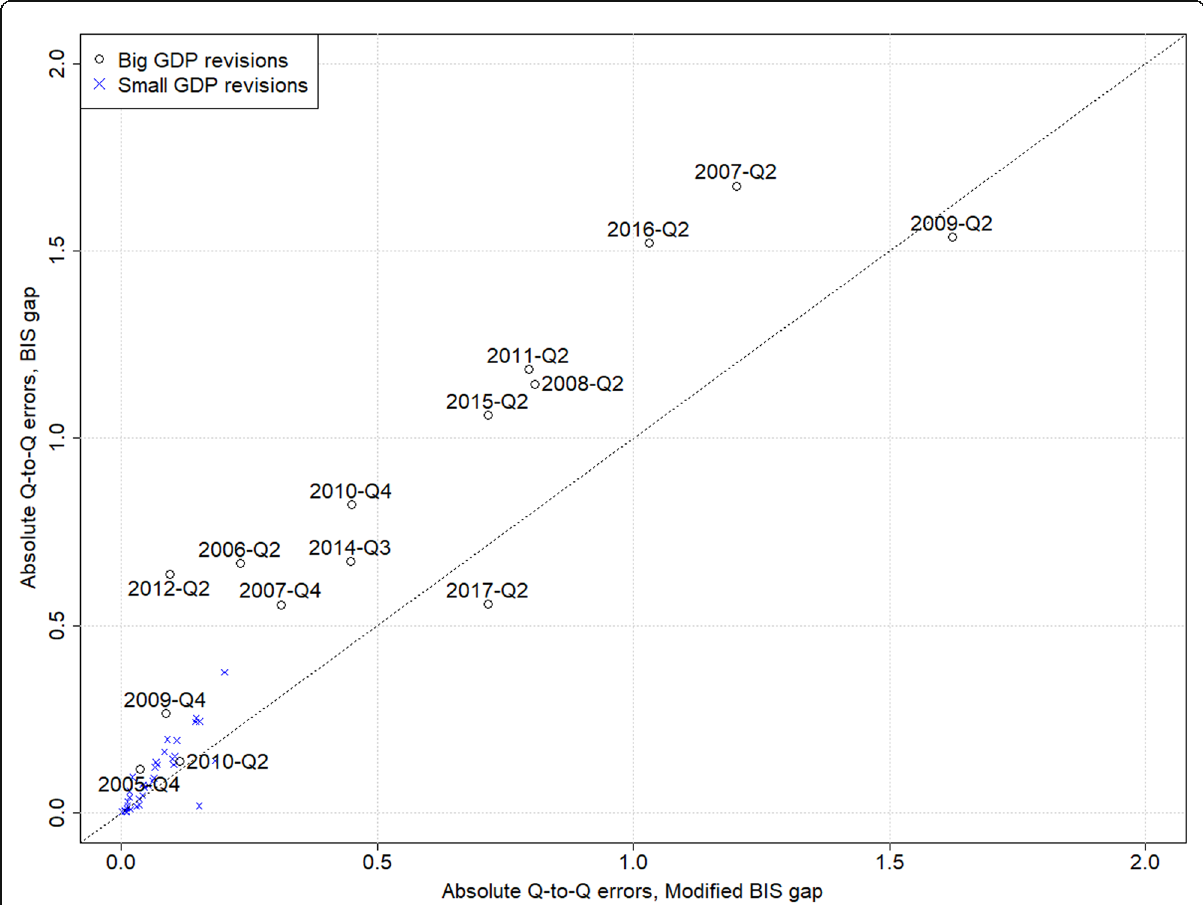
Fig. 5 Absolute quarterly errors resulting purely from GDP revisions. BIS gap ( y -axis) vs. modified BIS gap ( x -axis) in percentage points. Note: A GDP revision is classified as “ big ” if its relative difference, in absolute value, to the previous quarter ’ s vintage is larger than 0.66% at least once (see Fig. 3, in which 15 GDP vintages have at least one revision of greater than 0.66% and are denoted with dark red and red